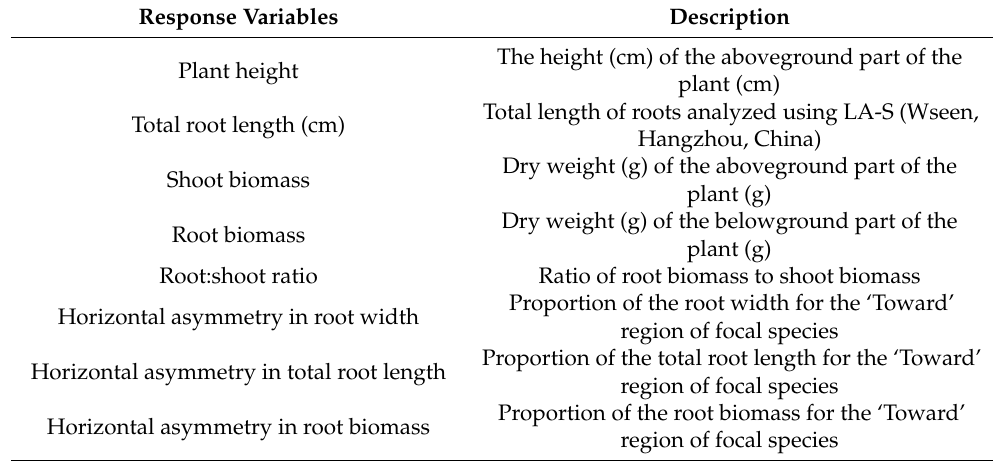
Table 2. Definite description of 8 response